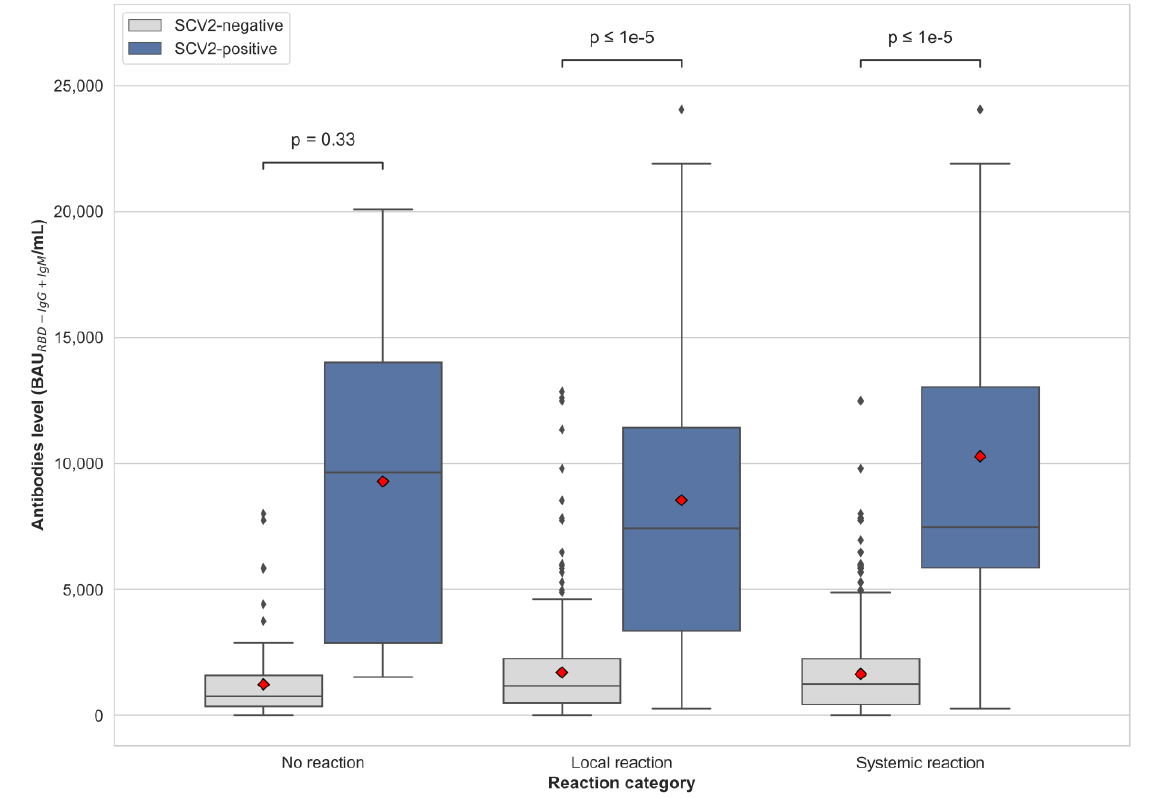
Figure 3. Antibody titer of anti-SARS-CoV2 antibody of patients who did not suffer any adverse reactions and those who presented local and systemic adverse reactions in SCV2-negative and SCV2- positive group, after the second vaccine dose. The red rhombus indicates the mean antibody level. For each box, the horizontal line inside the box shows the median. The ends of the box represent the 1st and 3rd quartiles, and the distance between them is called the interquartile range (IQR). The lower whisker end corresponds to a Q1 − 1.5 IQR value that is not an outlier observation; the upper whisker end Q3 + 1.5 IQR is expressed as the highest non-outlier observation.